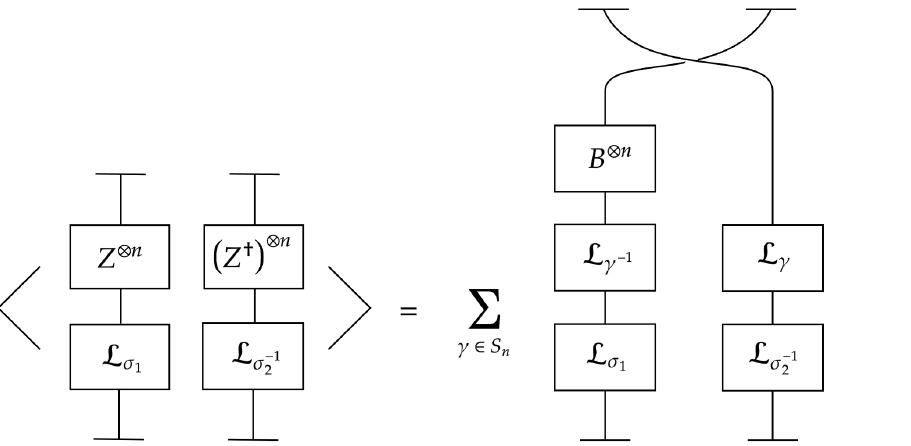
Figure 2 . The diagrammatic representation of the one-matrix correlator with coupling witness field. The expectation value of these gauge invariant operators can be written as a sum over permutations by exchanging Z ⊗ n and ( Z † ) ⊗ n for permutation operators L and L γ , inserting B ⊗ n and then γ − 1 swapping the indices. This tensor product of the coupling witness matrix B is incorporated when the ( γ − 1 , γ ) permutations are inserted via Wick contraction, using equation